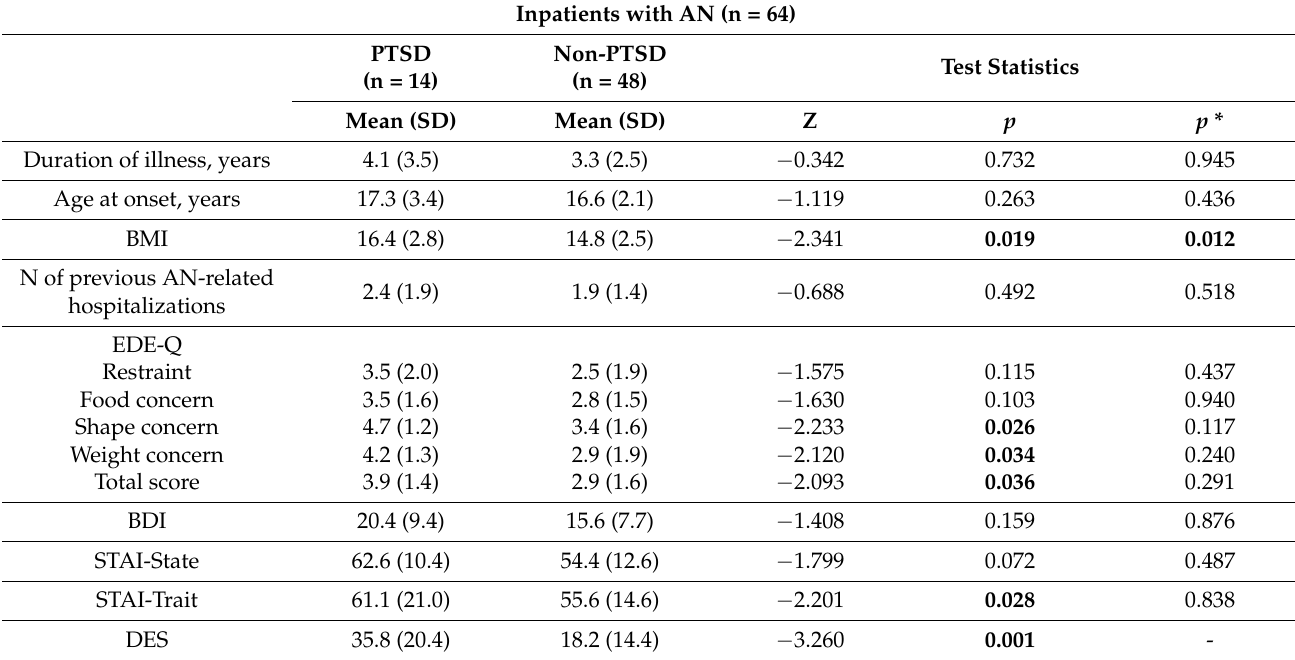
Table 4. Differences in clinical presentation between young patients with AN with and without PTSD